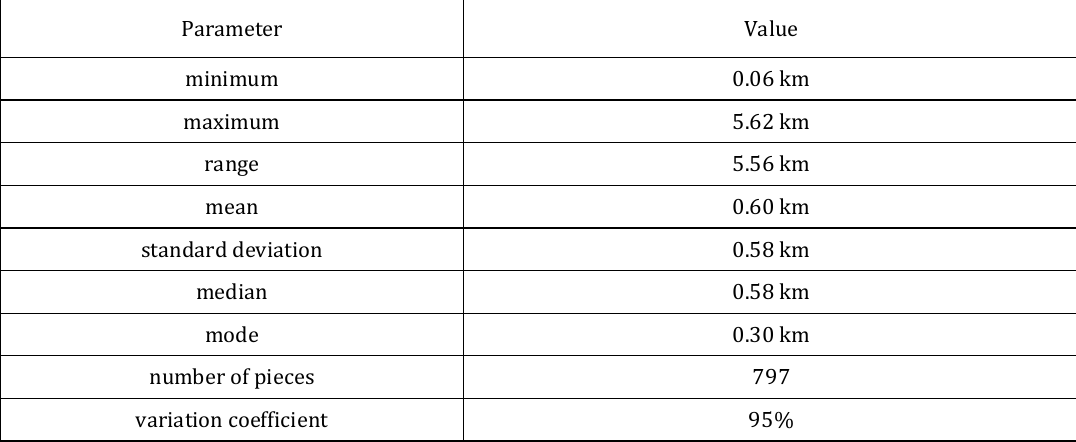
Table 1. Statistical data of line forms